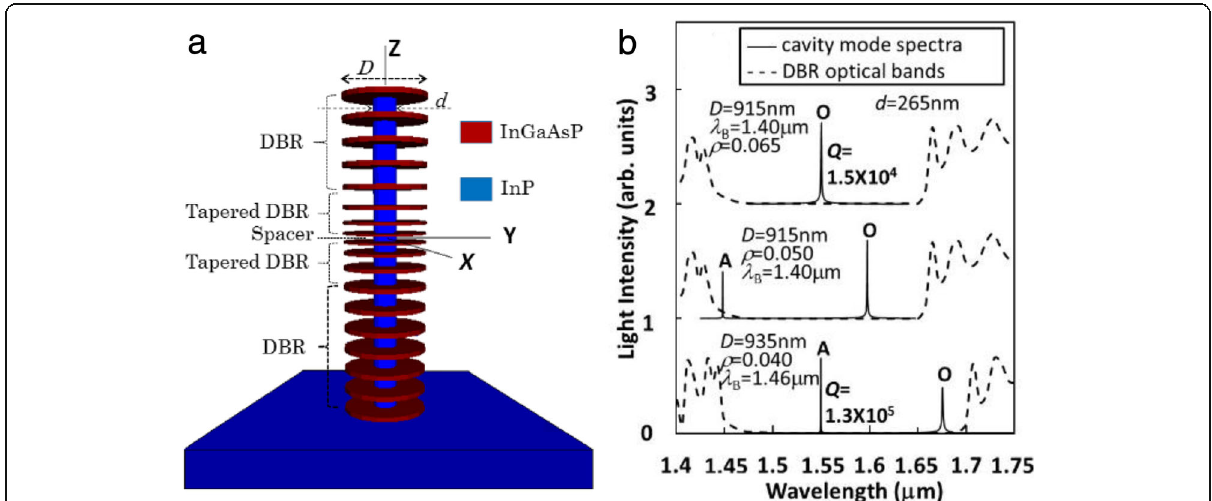
Fig. 1 a Three-dimensional schematic demonstration of the proposed cavity. b Examples of the calculated optical mode spectra with corresponding DBR optical bands. In b , the lines for different design conditions are vertically shifted for